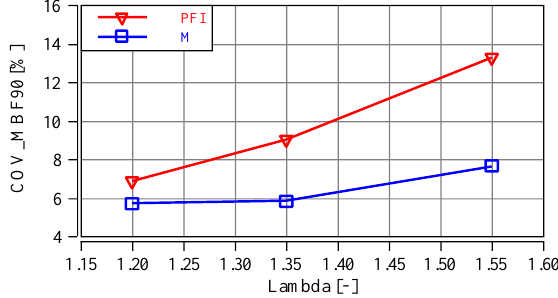
Fig. 11. Effects of injection system on coefficient of variation of 90% mass burned friction (MBF90%) for different charge composition As previously mentioned, the parameter relative Fig. 9. Distribution of peak pressure points for three different lambda values